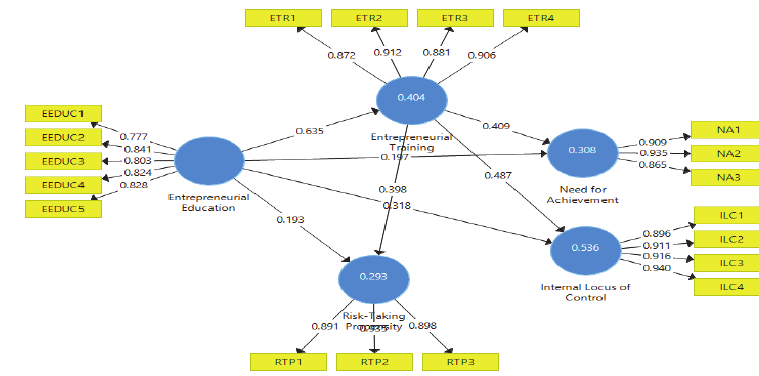
Fig. 2. Measurement Model (PLS Model)